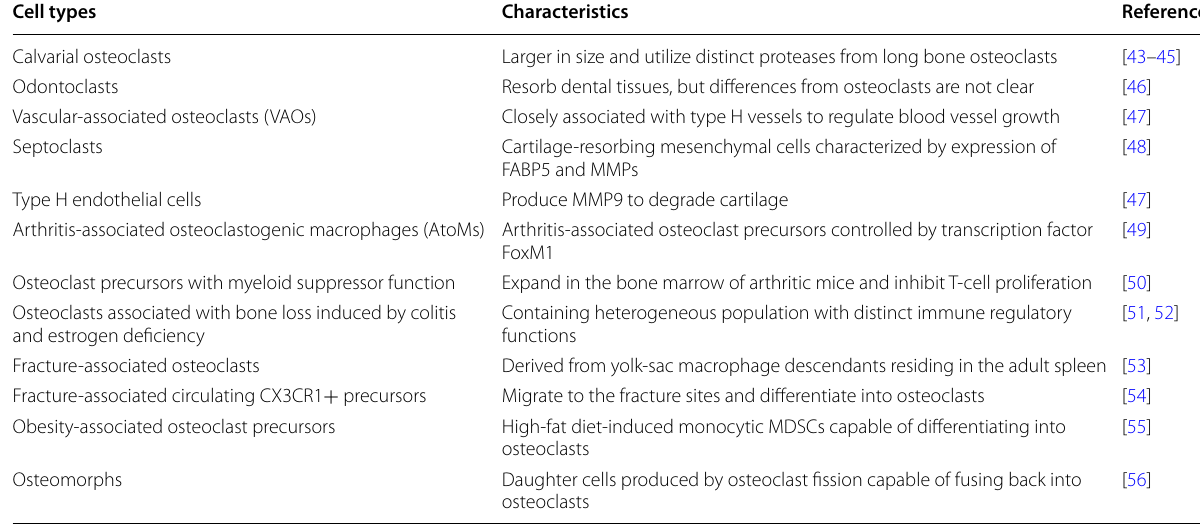
Table 1 The heterogeneity of hard tissue-resorbing cells. Diversity in hard tissue-resorbing cells at different sites and biological